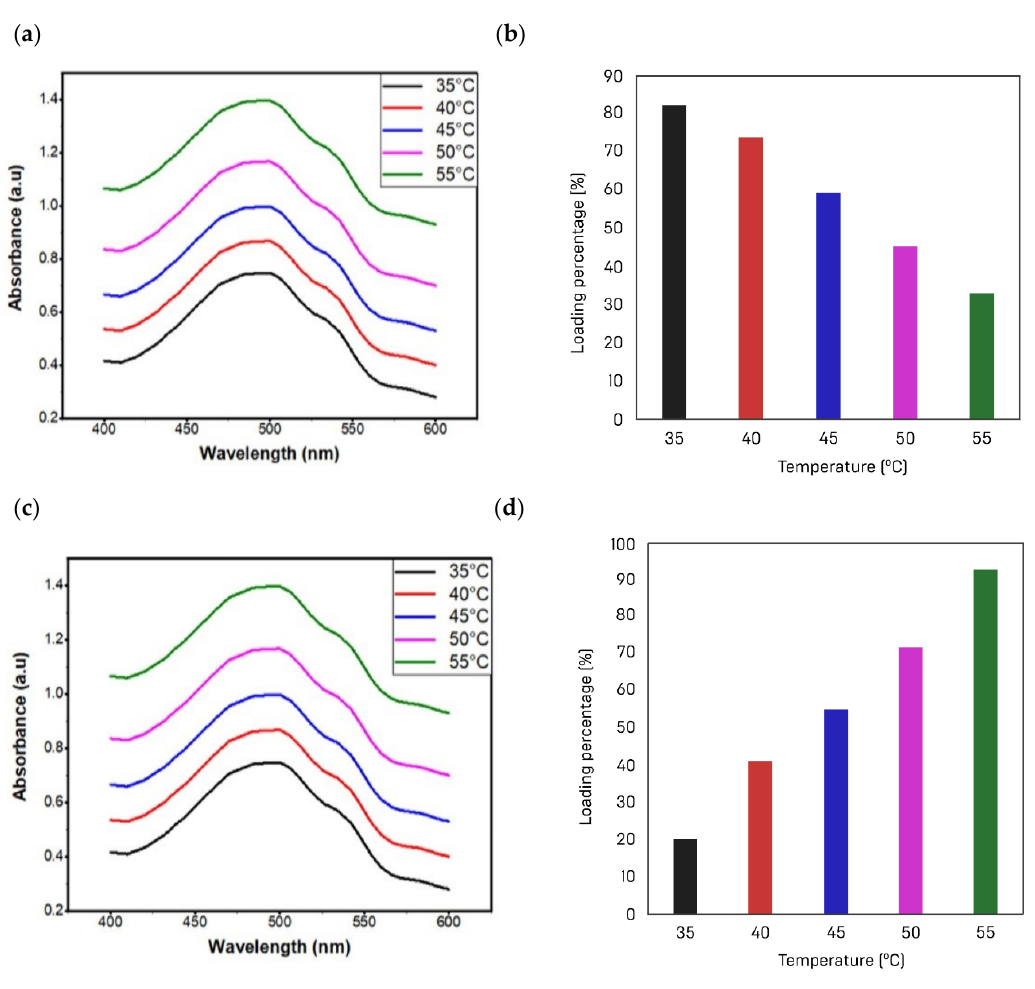
Figure 10. ( a ) Variation in UV absorbance as a function of loading temperature; ( b ) a bar graph illus- trates the reduction in loading capacity over temperature; ( c ) during desorption, the UV absorbance changes with temperature; ( d ) pattern of desorption over temperature is illustrated as a bar